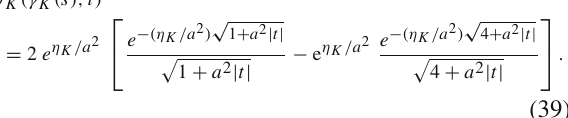
Fig. 10 Energy dependence oftheKFKparameters, obtainedbydirect analysis of d σ/ dt data at ISR energies, and at LHC energies 7 and 13 TeV. The dots mark the values of the parameters at reference values 52.8 GeV, 7 TeV and 13 TeV, as given in Table 5 √ s in TeV and units GeV − 2 for all quantities. These with forms as functions of the energy are shown in Fig.